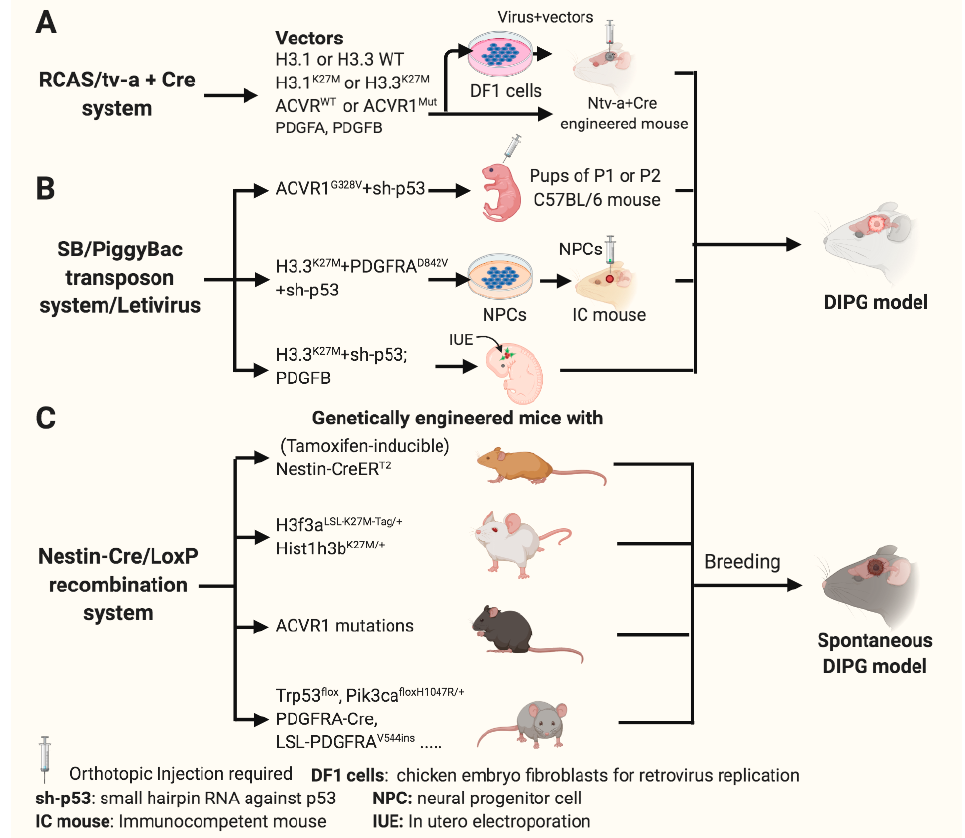
Figure 3. Genetically engineered mouse models (GEMMs) for DIPG using RACS/tv-a, SB/PiggyBac transposon with lentivirus, and Nestin-Cre/LoxP recombination systems. Schematic illustration demonstrating generation of GEMMs for DIPG. ( A ) Vectors were constructed with replication-competent avian sarcoma-leukosis virus long terminal repeat splice acceptor (RCAS/Tv-a). These viral vectors were either amplified with DF1 cells prior to inoculation (( A ) top panel) or directly inoculated (( A ) bottom panel) into the pons of Nestin-Cre engineered Ntv-a or Ntv-a; Ink4a-ARF − / − ; Ntv-a; p53 fl/fl , and Ntv-a; PTEN fl/fl mice. ( B ) Vectors constructed with the Sleeping Beauty Piggy/Bac transposon in combination with lentivirus system were injected into postnatal day 1 (P1) or 2 (P2) C57BL/6 mice (( B ) top panel) or transduced into neural progenitor cells (NPCs) (( B ) middle panel) followed by orthotopic NPC pontine inoculation, vectors were also administered via in utero electroporation (IUE) (( B ) bottom panel). ( C ) Mouse models with various molecular backgrounds associated with DIPG were developed with the Nestin-Cre/LoxP recombination system and bred to generate GEMMs for spontaneous DIPG.